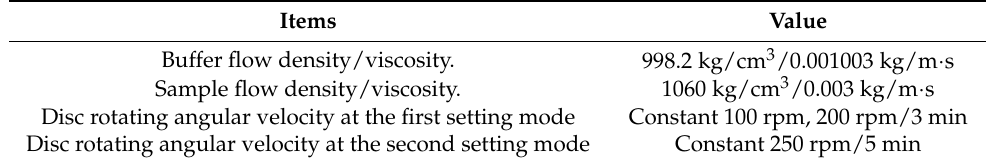
Table 2. Illustration of the boundary value setting with Ansys Fluent